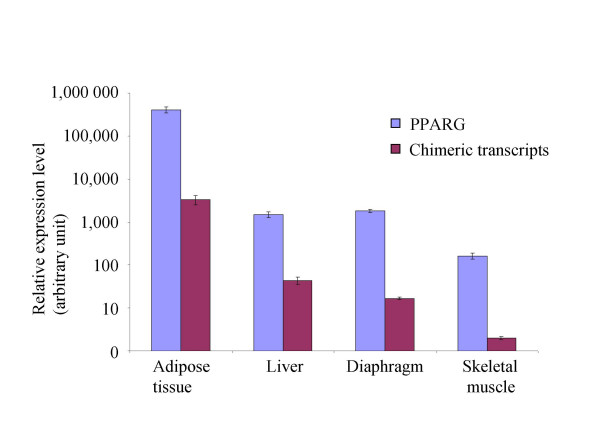
Relative expression levels of the normal PPARG transcripts and the chimeric transcripts assessed by semi-quantitative RT-PCR in four different tissues from one individual. Error bars stand for the variation between the values obtained from triplicates for each experiment.